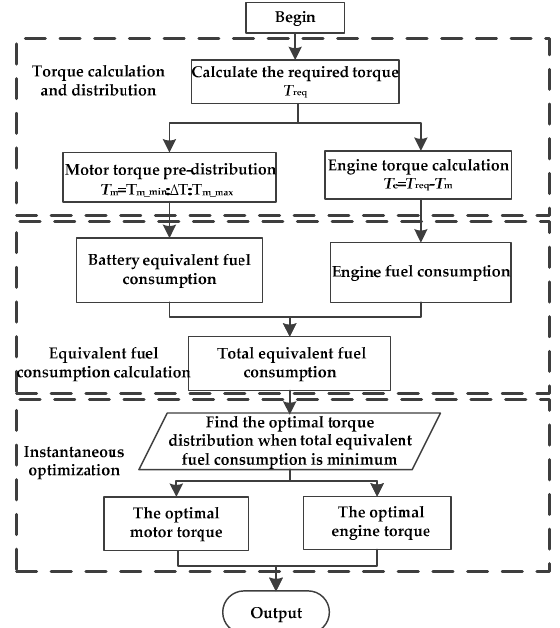
Figure 13. The principle of ECMS.